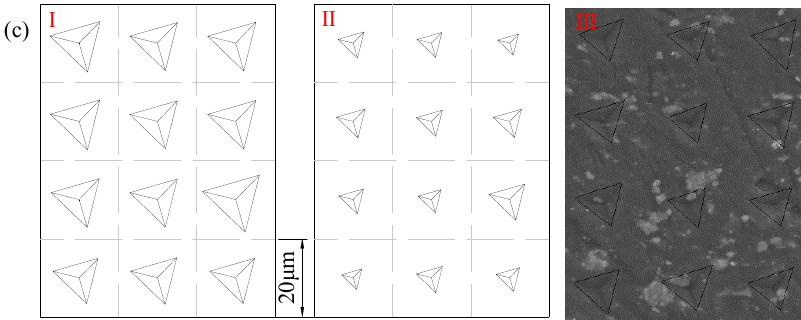
Figure 10. Profiles of indents of ( a ) shale, ( b ) mudstone and ( c ) coal.